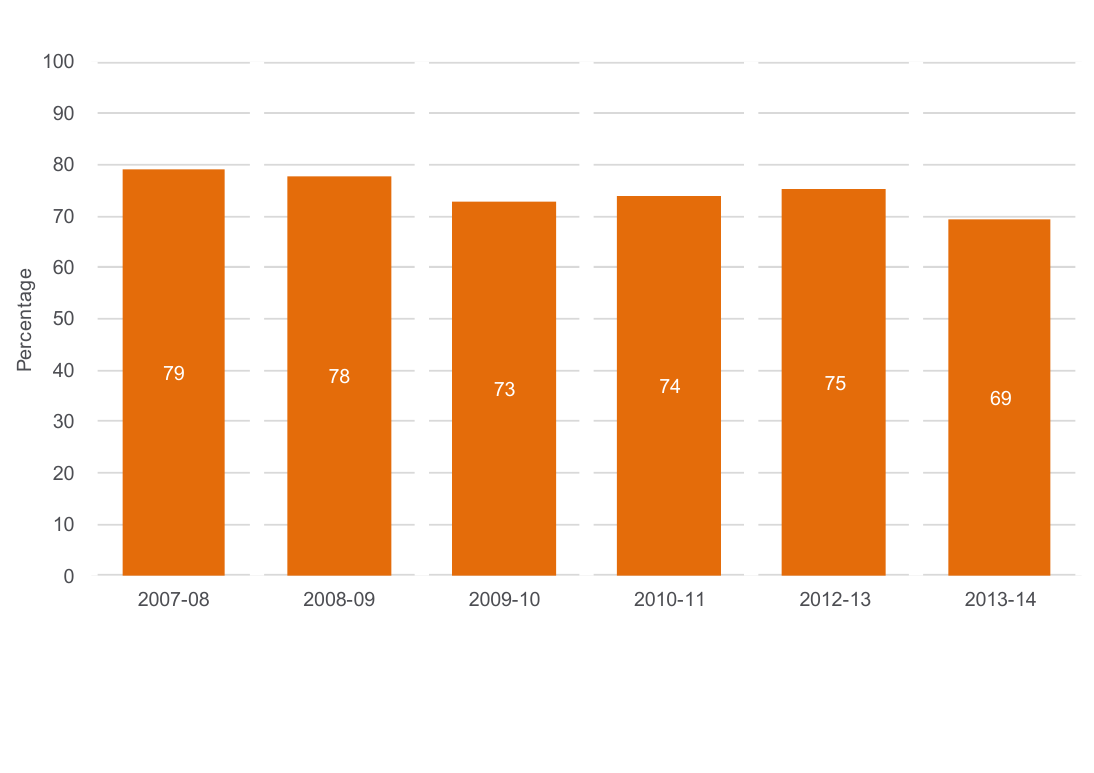
Figure 19: Proportion of people who think it is important to feel that they can influence decisions in their local area, 2007-08 to